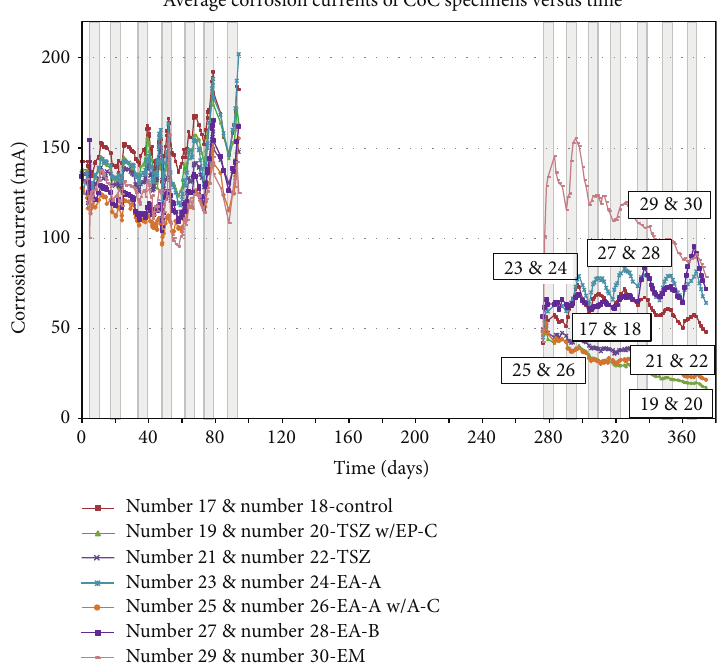
Figure 8: Average corrosion currents of specimens.